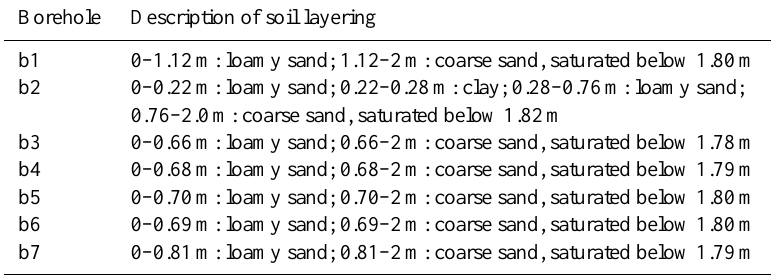
Table 1. Observations of soil layering from borehole samplings (b1, b2, ..., b7 shown in Fig. 3). Borehole